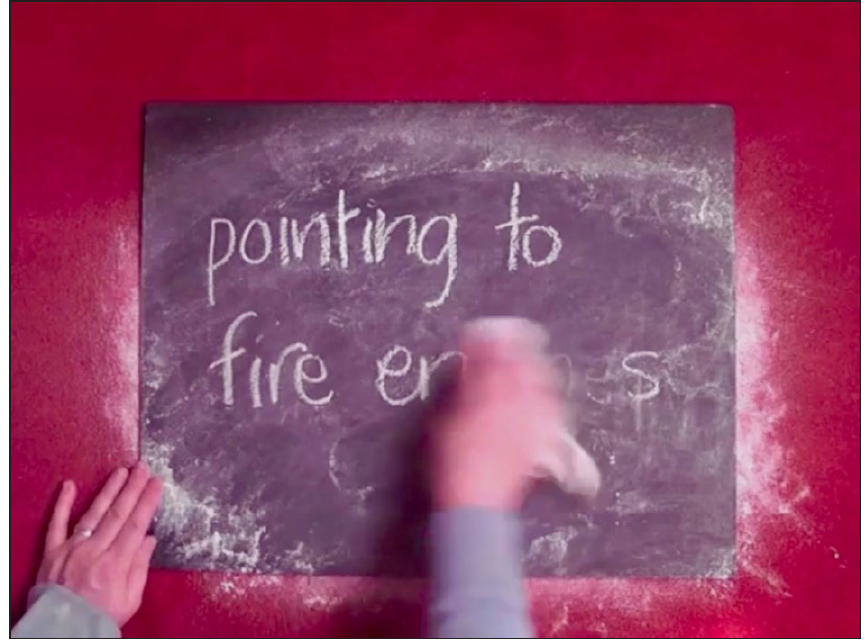
Figure 3: 50 things my son doesn’t need me for